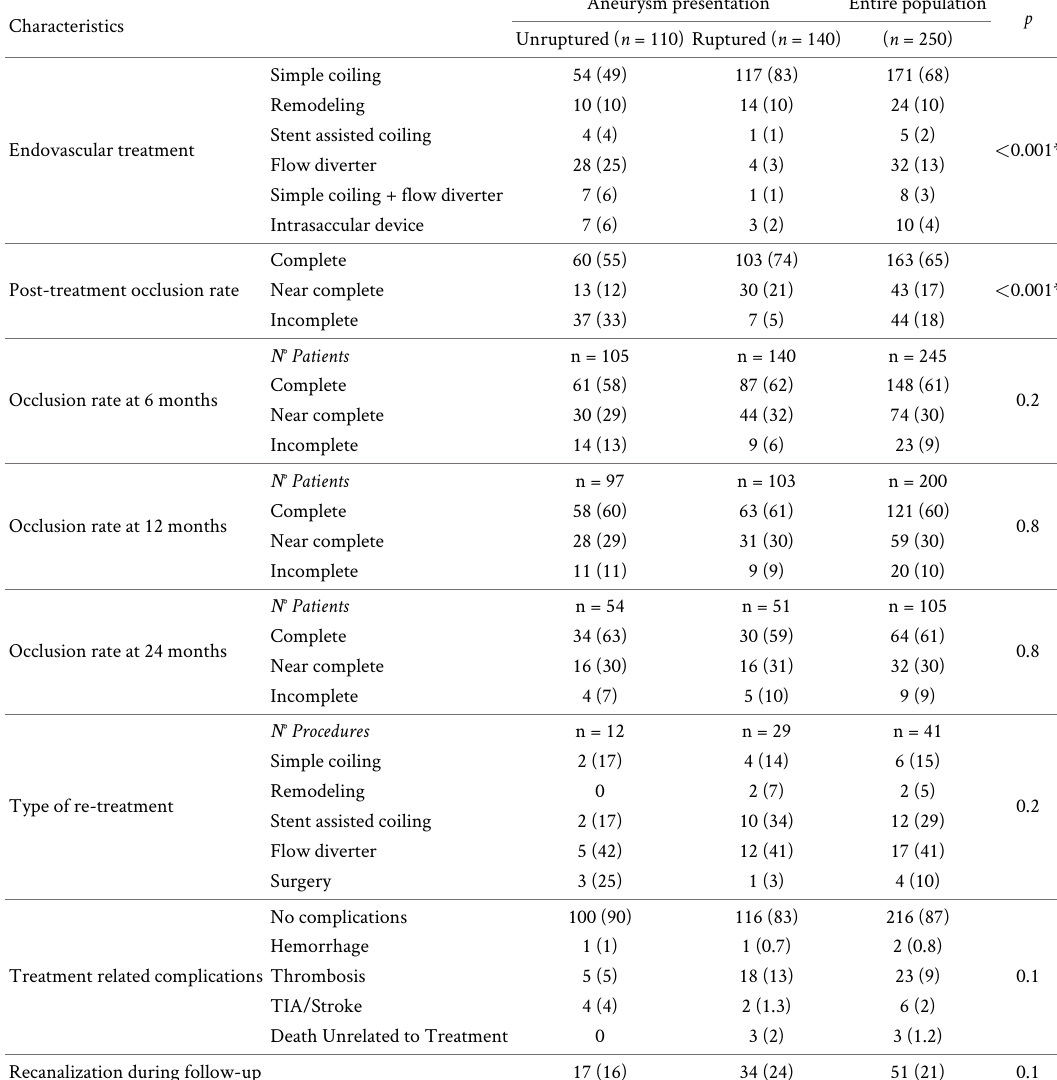
Table 2. Treatments, radiological outcomes and complications split by aneurysm presentation (unruptured/ruptured).